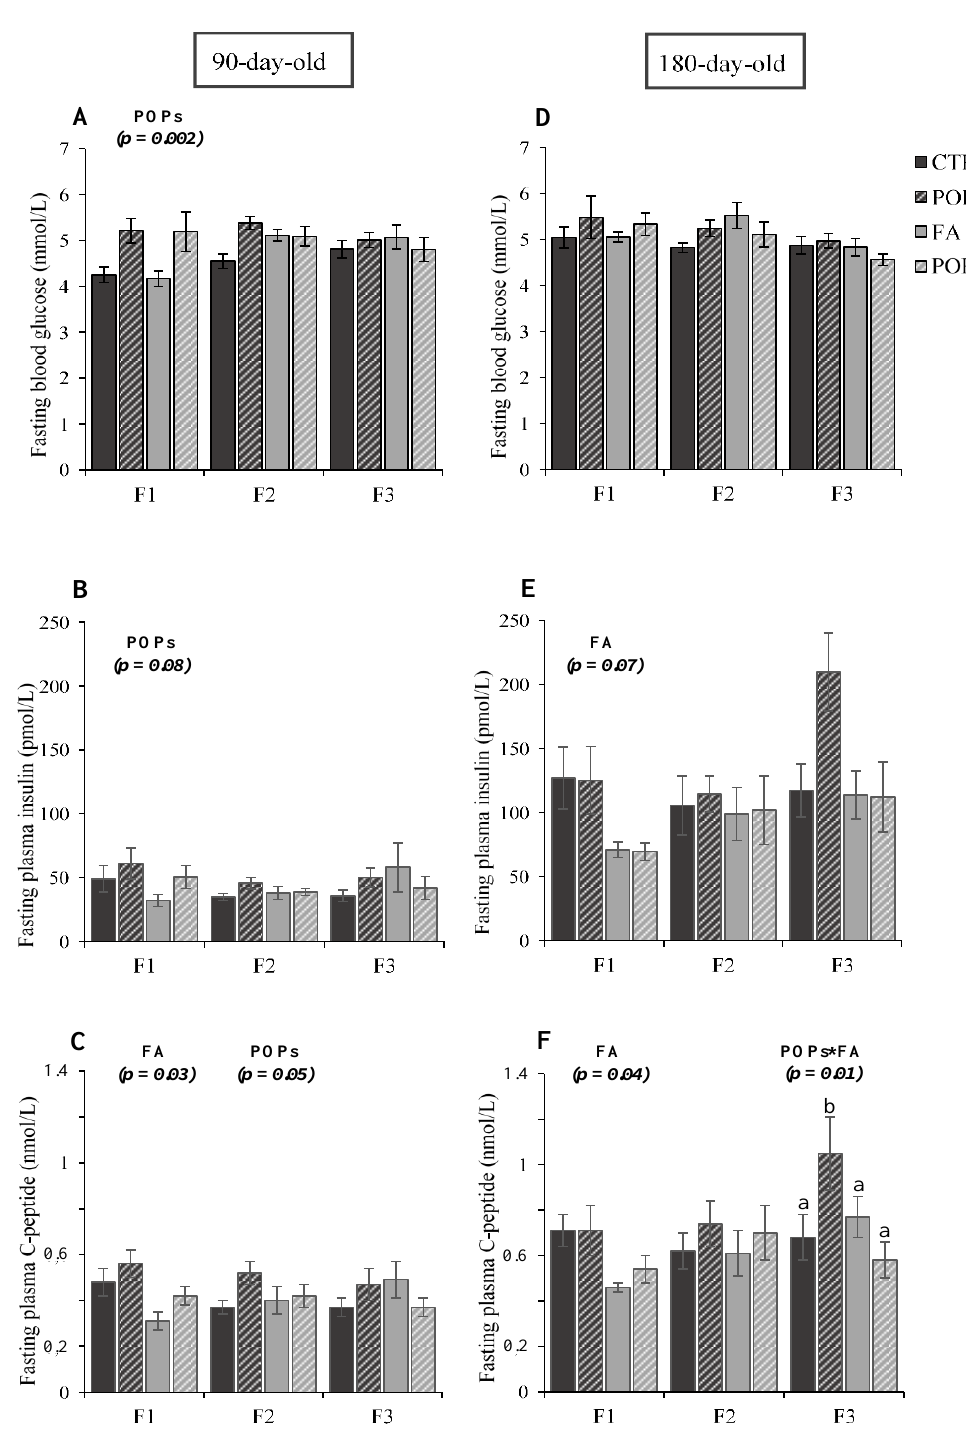
Figure 2. Impacts of POP exposure and/or folic acid (FA) supplementation of F0 female rats on fasting blood glucose, plasma insulin and C-peptide in F1, F2 and F3 male rats aged 90 days ( A – C ) and 180 days ( D – F ). Results are expressed as mean ± SEM (n = 9 or 10). Analysis of variance (ANOVA) for a 2 × 2 factorial experiment was used to calculate main effects of POPs and FA and the POPs*FA interaction. A Tukey post hoc test was used when an interaction was significant. Bars with differing letters are significantly different ( p ≤ 0.05).